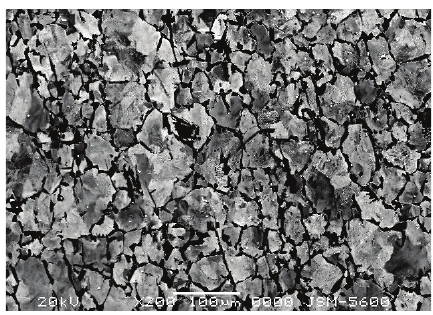
Figure 1: SEM micrograph of specimen A.